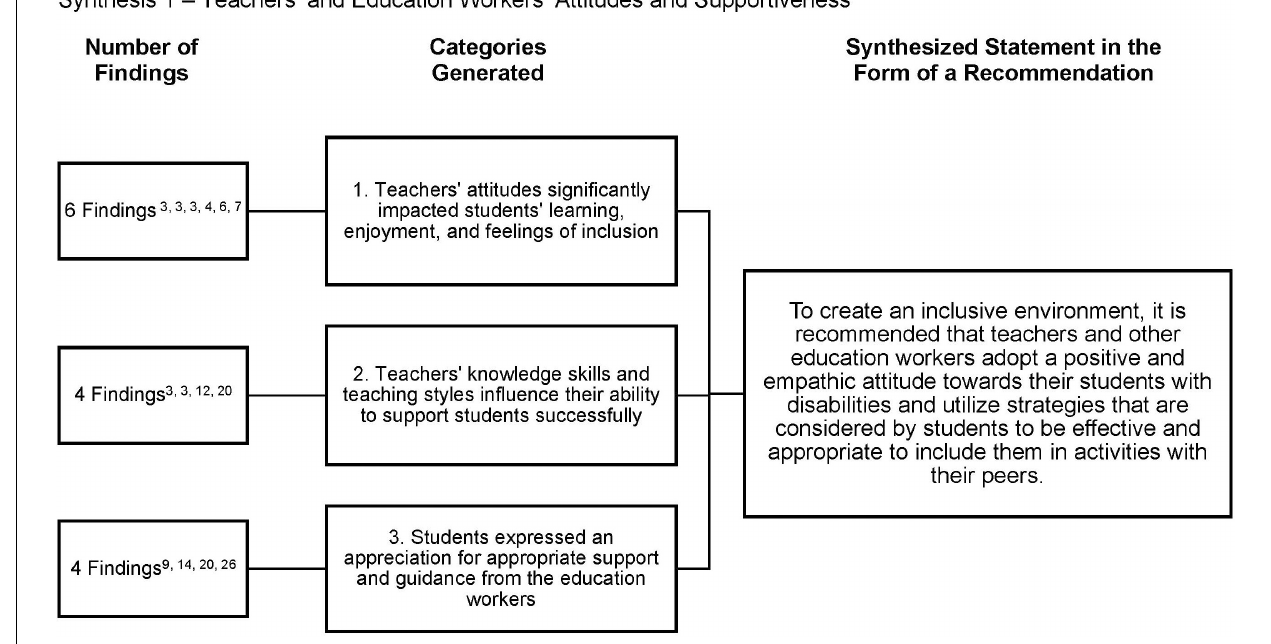
FIGURE 2 | Synthesis 1 – teachers’ and education workers’ attitudes and supportiveness. The superscript numbers under “Number of Findings” corresponds to the study numbers in Table 3 .